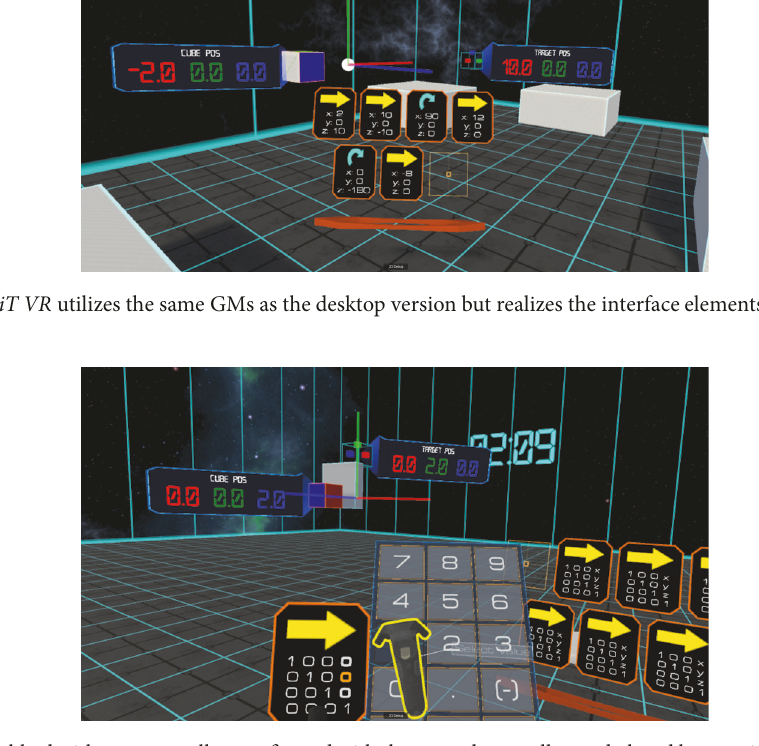
Figure 9: AT cards are grabbed with one controller, configured with the second controller, and played by pressing the first controller’s trigger button in GEtiT VR